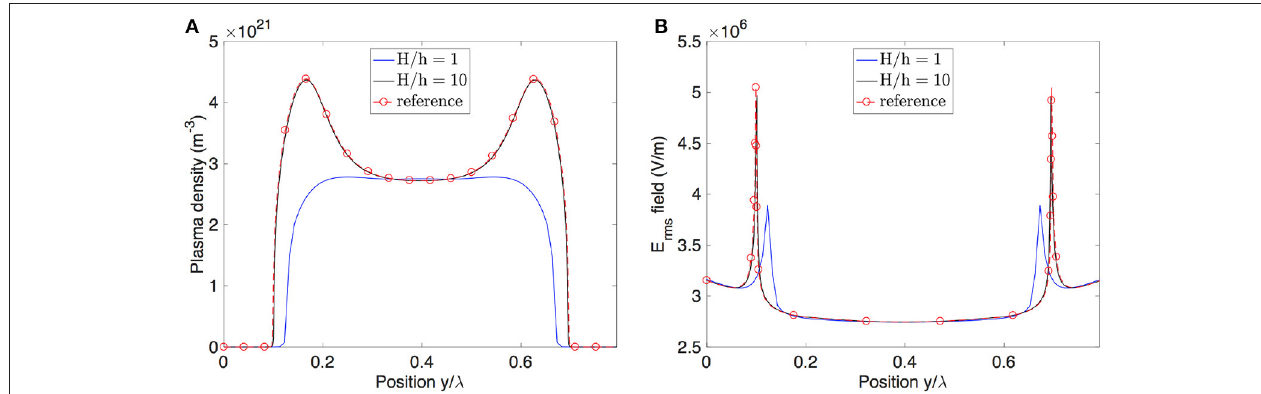
FIGURE 9 | Profile of plasma density (A) and rms electric field (B) along the streamer axis, corresponding to conditions of Figure 7 at 110 ns, without (blue solid line) and with (black solid line) patch H / h = 10 and for the reference case (red solid line with circles).